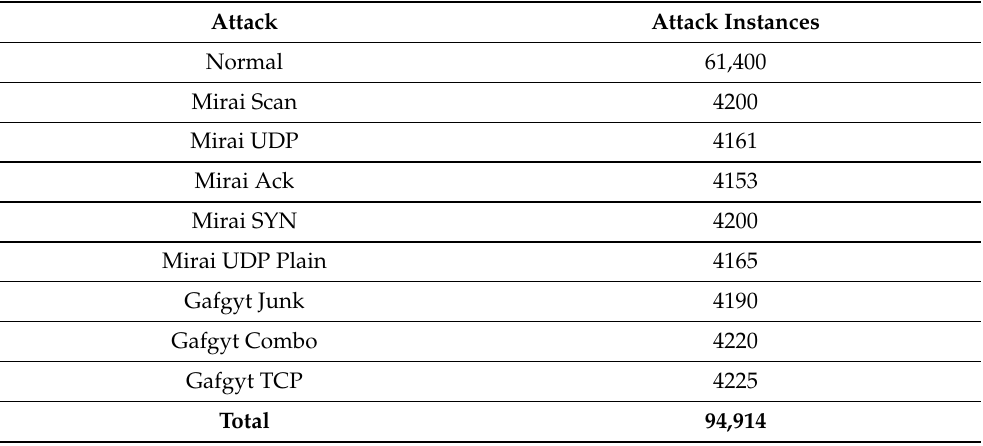
Table 3. N-BaIoT dataset details.